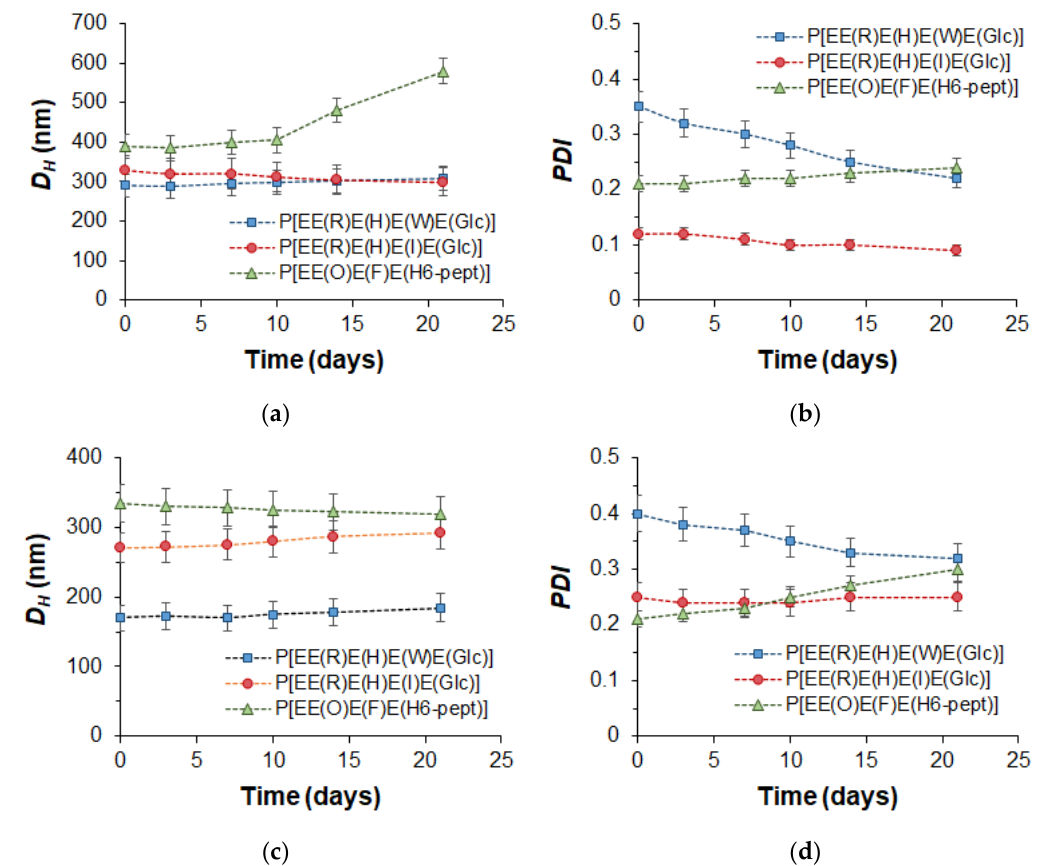
Figure 6. Monitoring of the storage stability of the empty ( a,b ) and PTX ‐ loaded ( c,d ) nanoparticles (DLS; 20 °C, H 2 O): hydrodynamic diameter ( D H ) ( a,c ) and PDI ( b,d ). (DLS; 20 ◦ C, H 2 O): hydrodynamic diameter ( D H ) ( a , c ) and PDI ( b , d